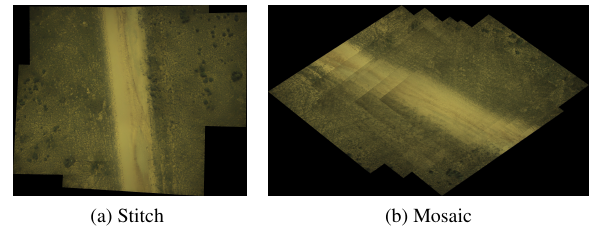
Figure 5: Stitch and mosaic compositions